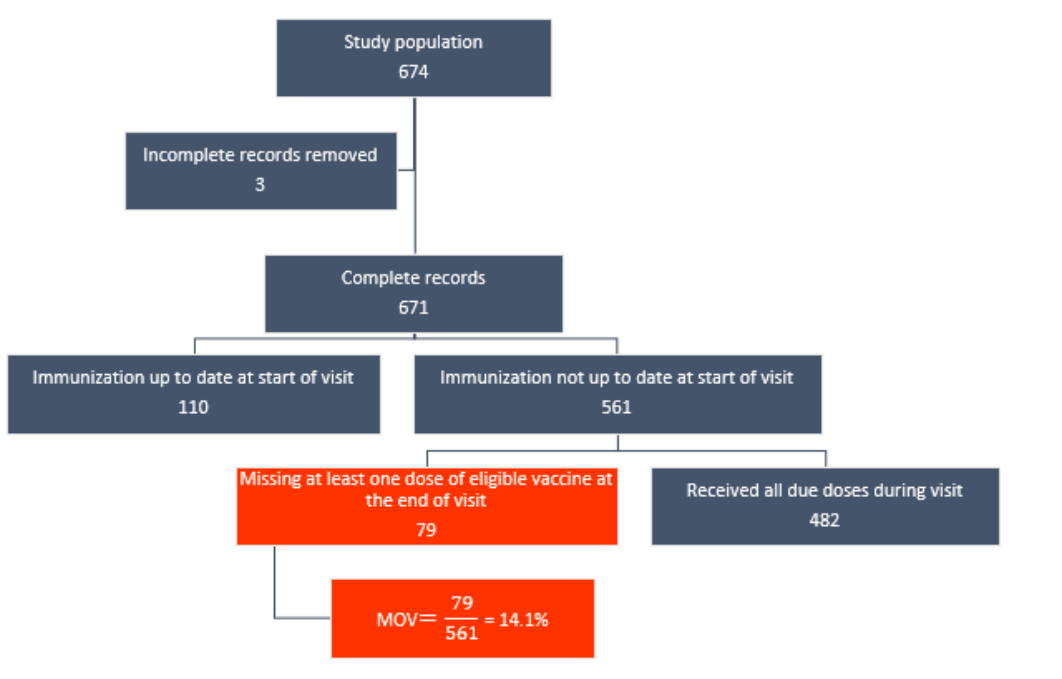
Figure 1. Flowchart of MOV prevalence estimation among children aged 0–23 months in Cape Town.